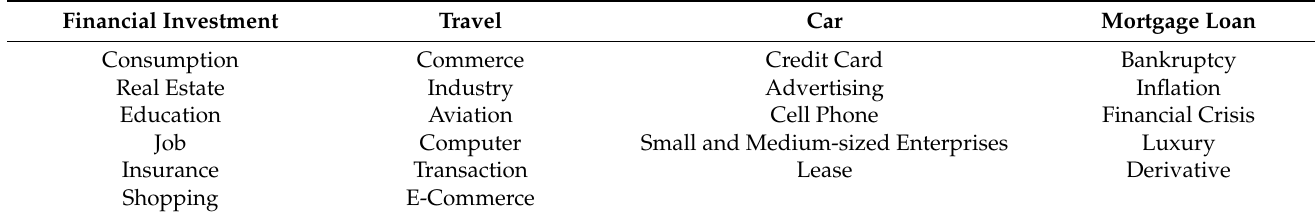
Table 1. Initial keyword library.